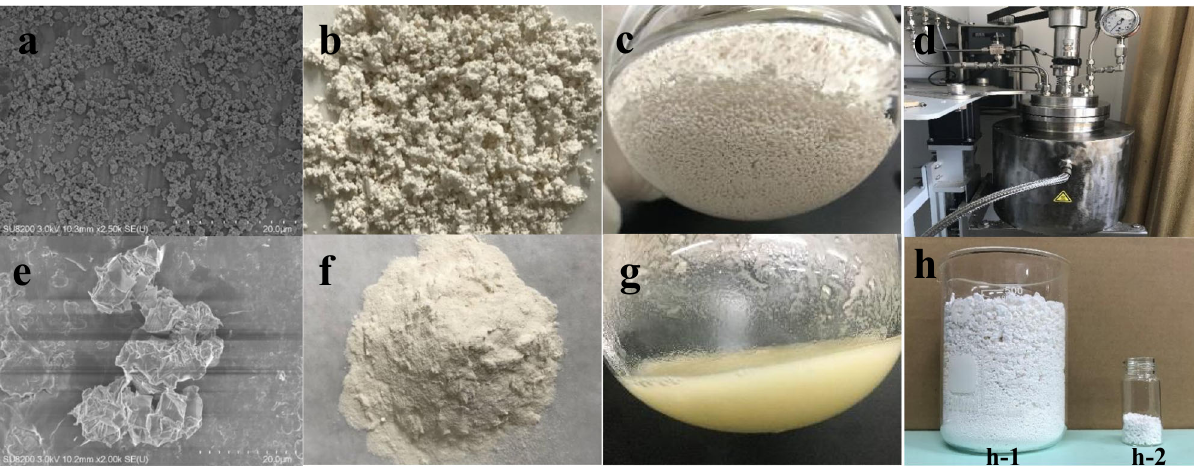
Fig. 4 Polymer morphology and large-scale polymerization. a SEM image of polyethylene samples prepared from Ni-Na-SiO 2 . b , c Polyethylene samples prepared from Ni-Na-SiO 2 . d 2.5 L polymerization reactor. e SEM image of polyethylene samples prepared from Ni . f , g Polyethylene samples prepared